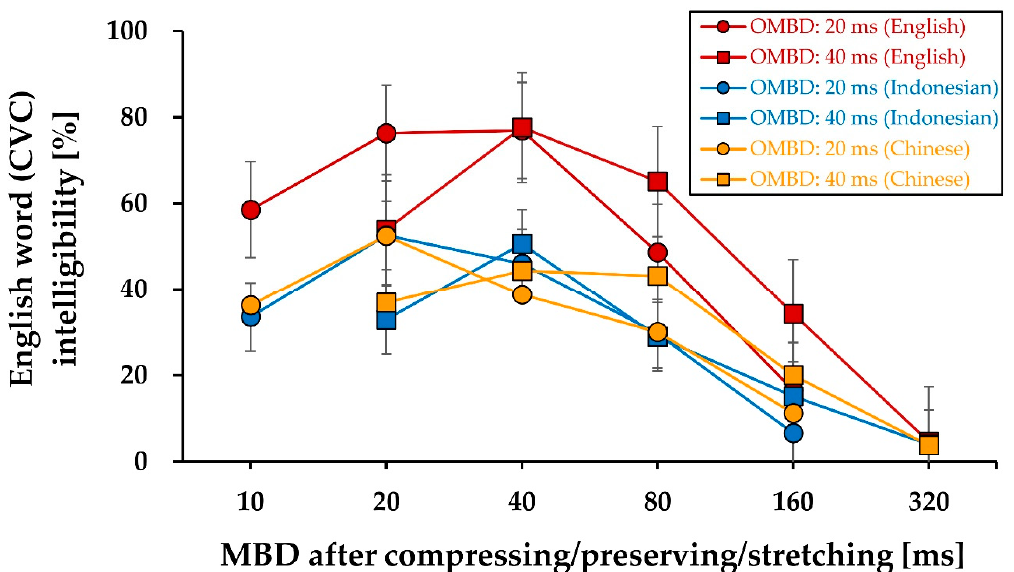
Figure 3. English word identification accuracy (intelligibility) for mosaic speech as functions of MBD after compressing / preserving / stretching (English, n = 19; Indonesian, n = 19; Chinese, n = 20). The data for half-phase and whole-phase types are collapsed. Error bars indicate standard errors.